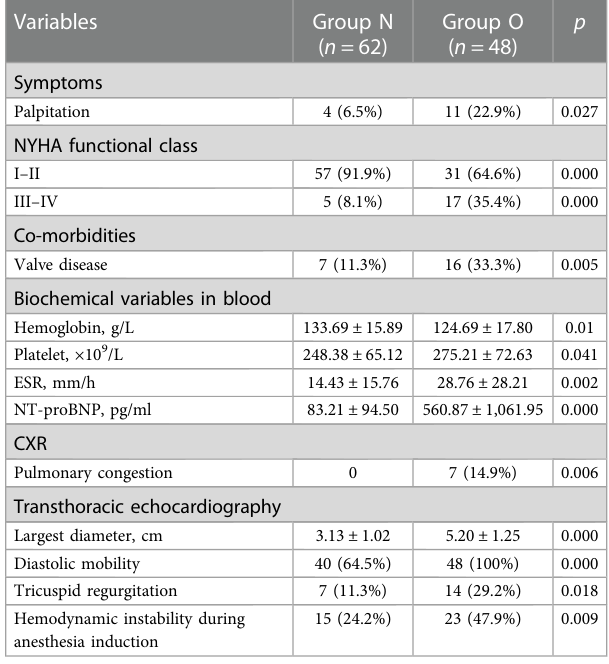
TABLE 4 Comparison between two